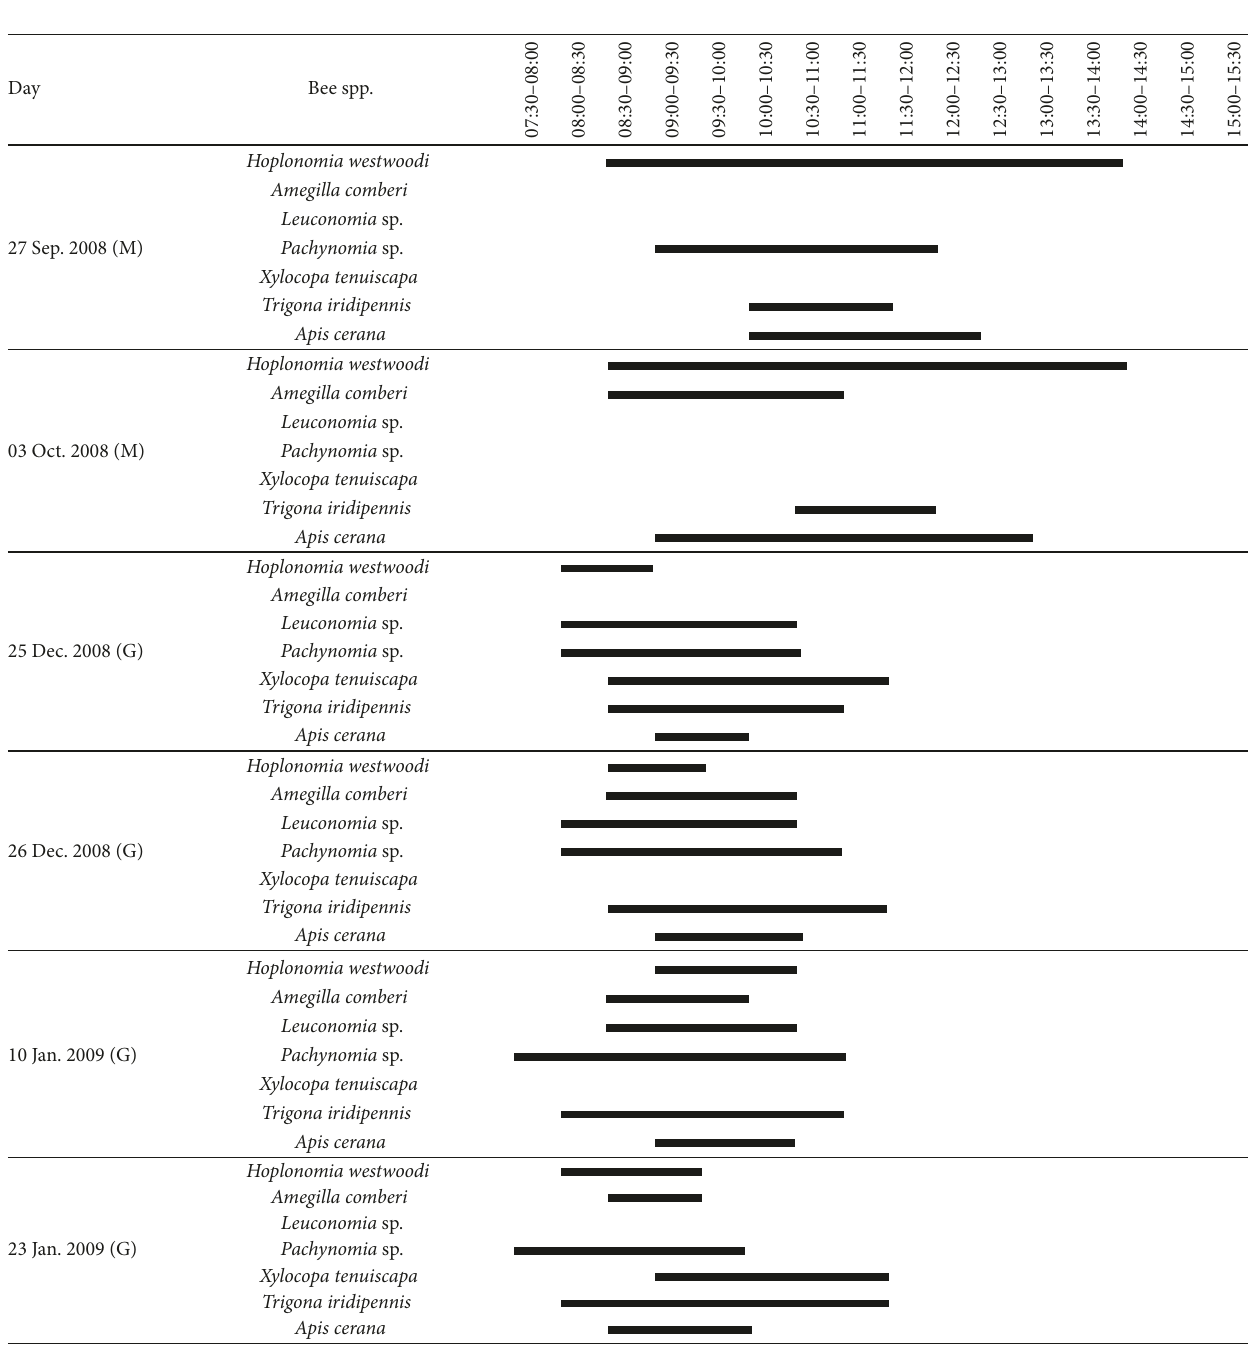
Figure 1: Activity period of bees at Miwatura (M) and Gelioya (G) sites in two and four sunny days, respectively, at flowers of S. melongena . Range in temperature ( ∘ C), rainfall (mm), and relative humidity during the time period of observations for the six days: 27